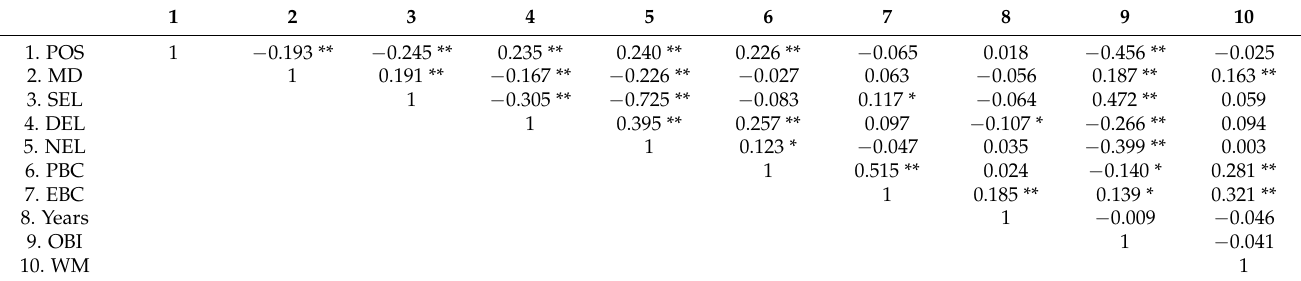
Table 2. Correlations between measures, years of practice.